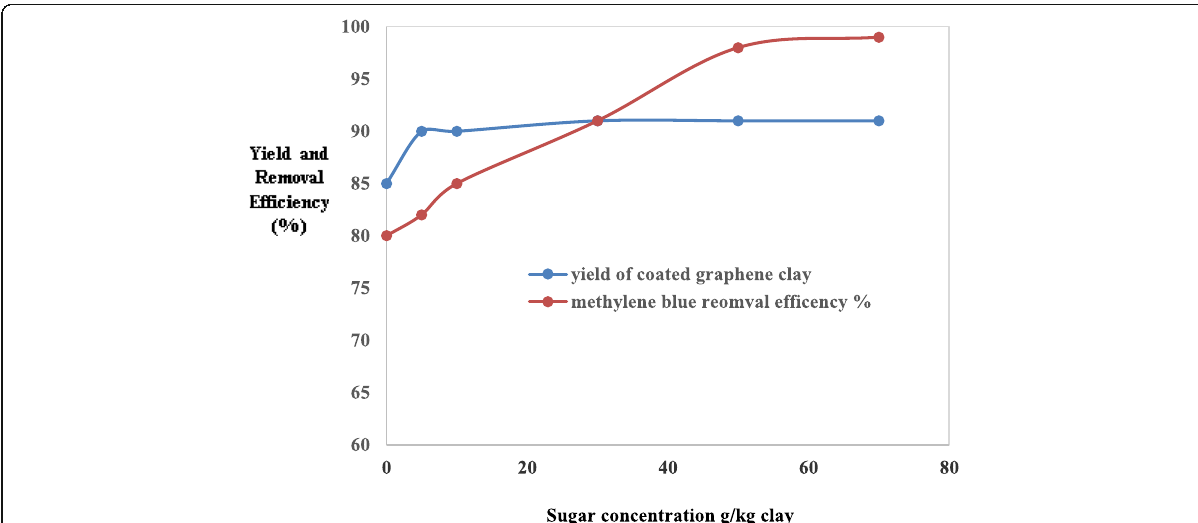
Fig. 6 Effect of sugar concentration on both bentonite coated graphene oxide yield and methylene blue removal efficiency. (Bentonite substrate 100 g, sulfuric acid 150 g, water 300 ml, and stirring time 30 min at 100